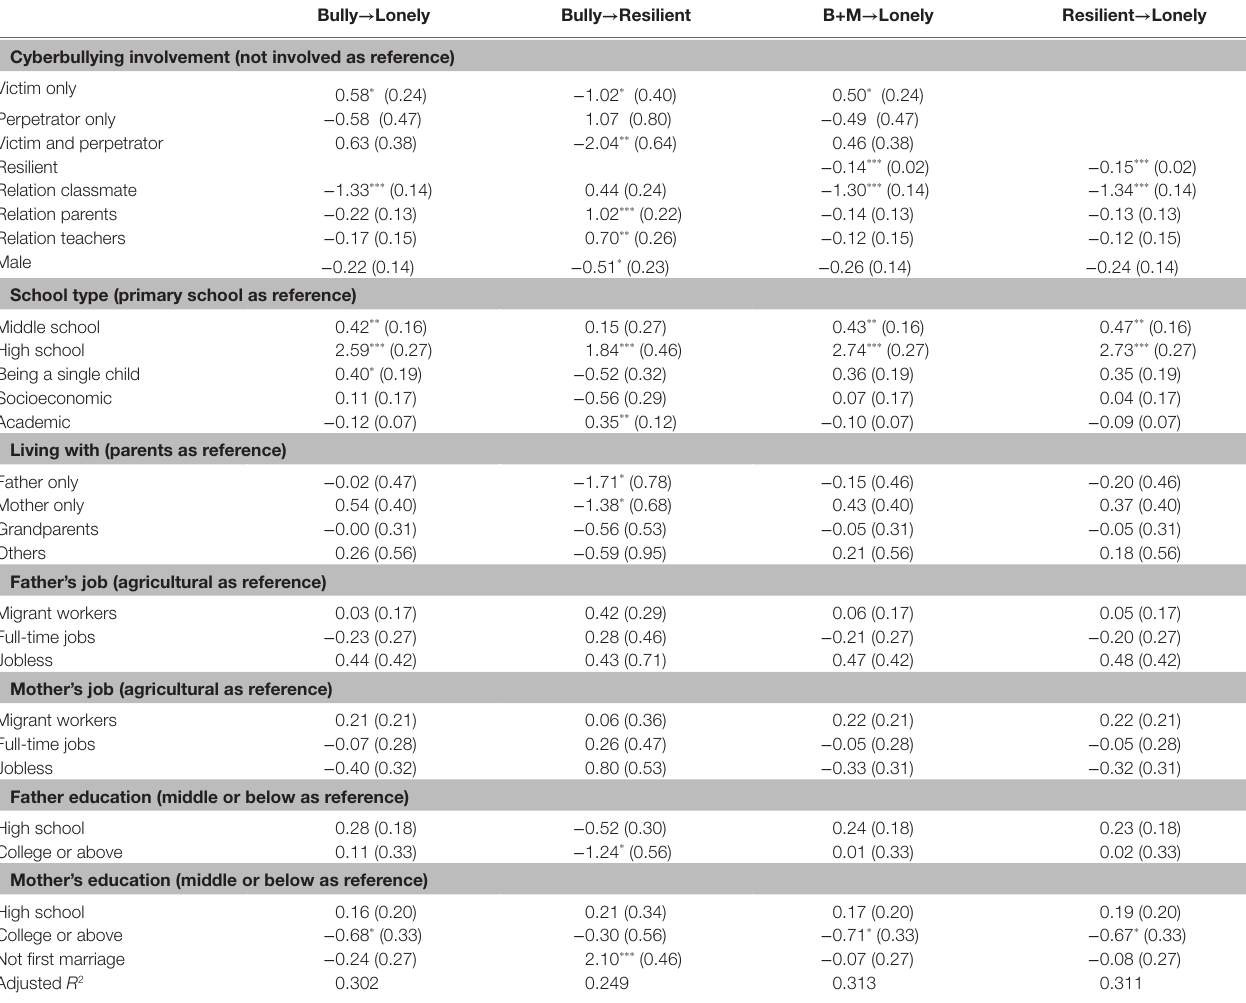
TABLE 3 | Cyberbullying involvement, resilient coping, and loneliness ( N =1,111). Bully → Lonely Bully → Resilient B+M → Lonely Resilient →